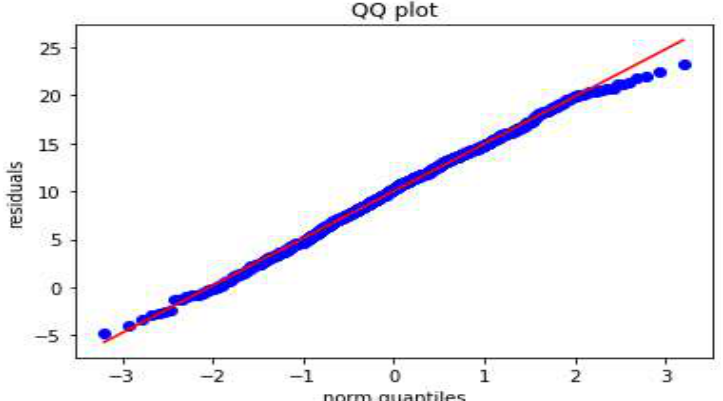
Table 3. Revenue loss prediction error of different experiments for the thunderstorm category. Experiment